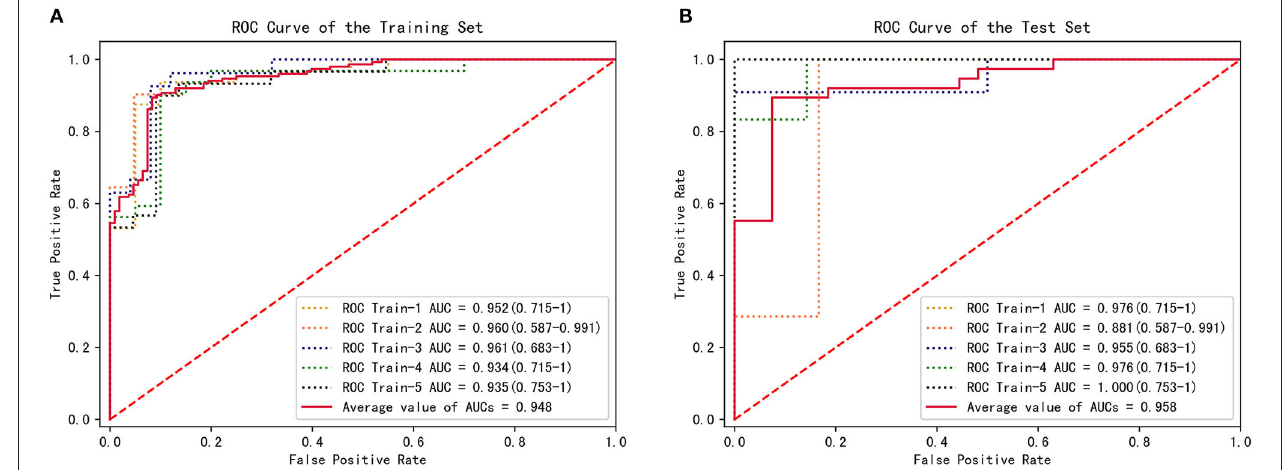
FIGURE 5 | CFD performance for the diagnosis of CoA. (A) ROC for CoA diagnosis in the training set. (B) ROC for CoA diagnosis in the test